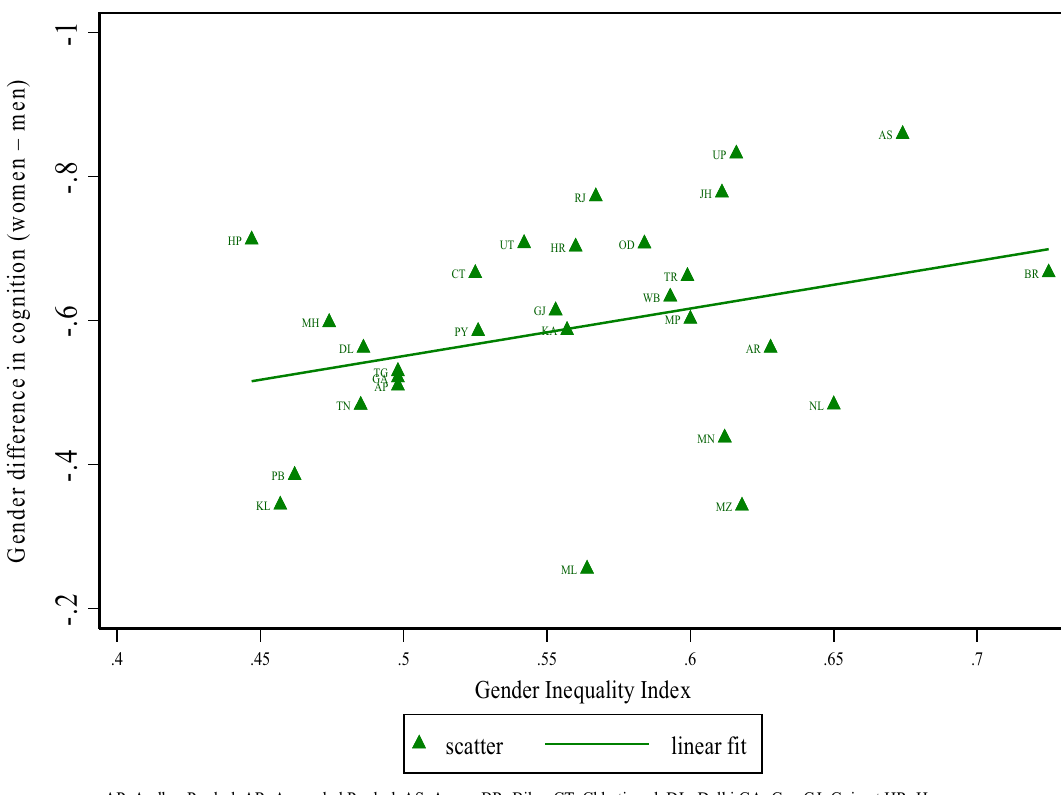
Figure 3. State-level gender inequality and average gender difference in cognition